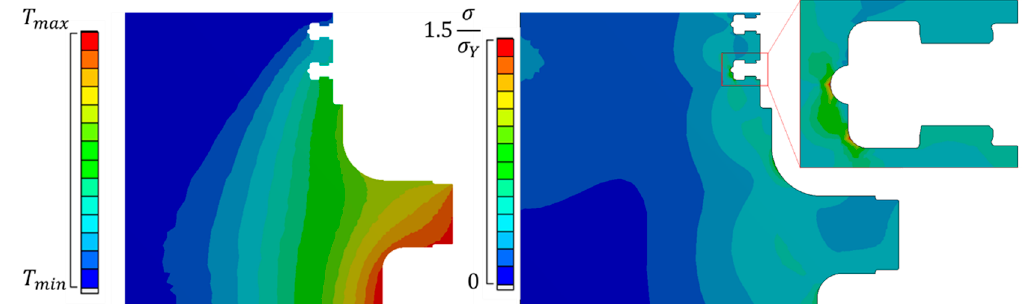
Figure 2. Temperature and Von Mises Stress contour plots at when maximum stress is reached for a typical ST start-up scenario © 2020 Baker Hughes Company—All rights reserved.